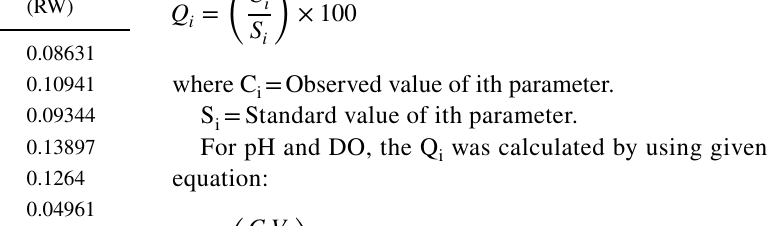
Table 1 Relative weight of each selected parameter